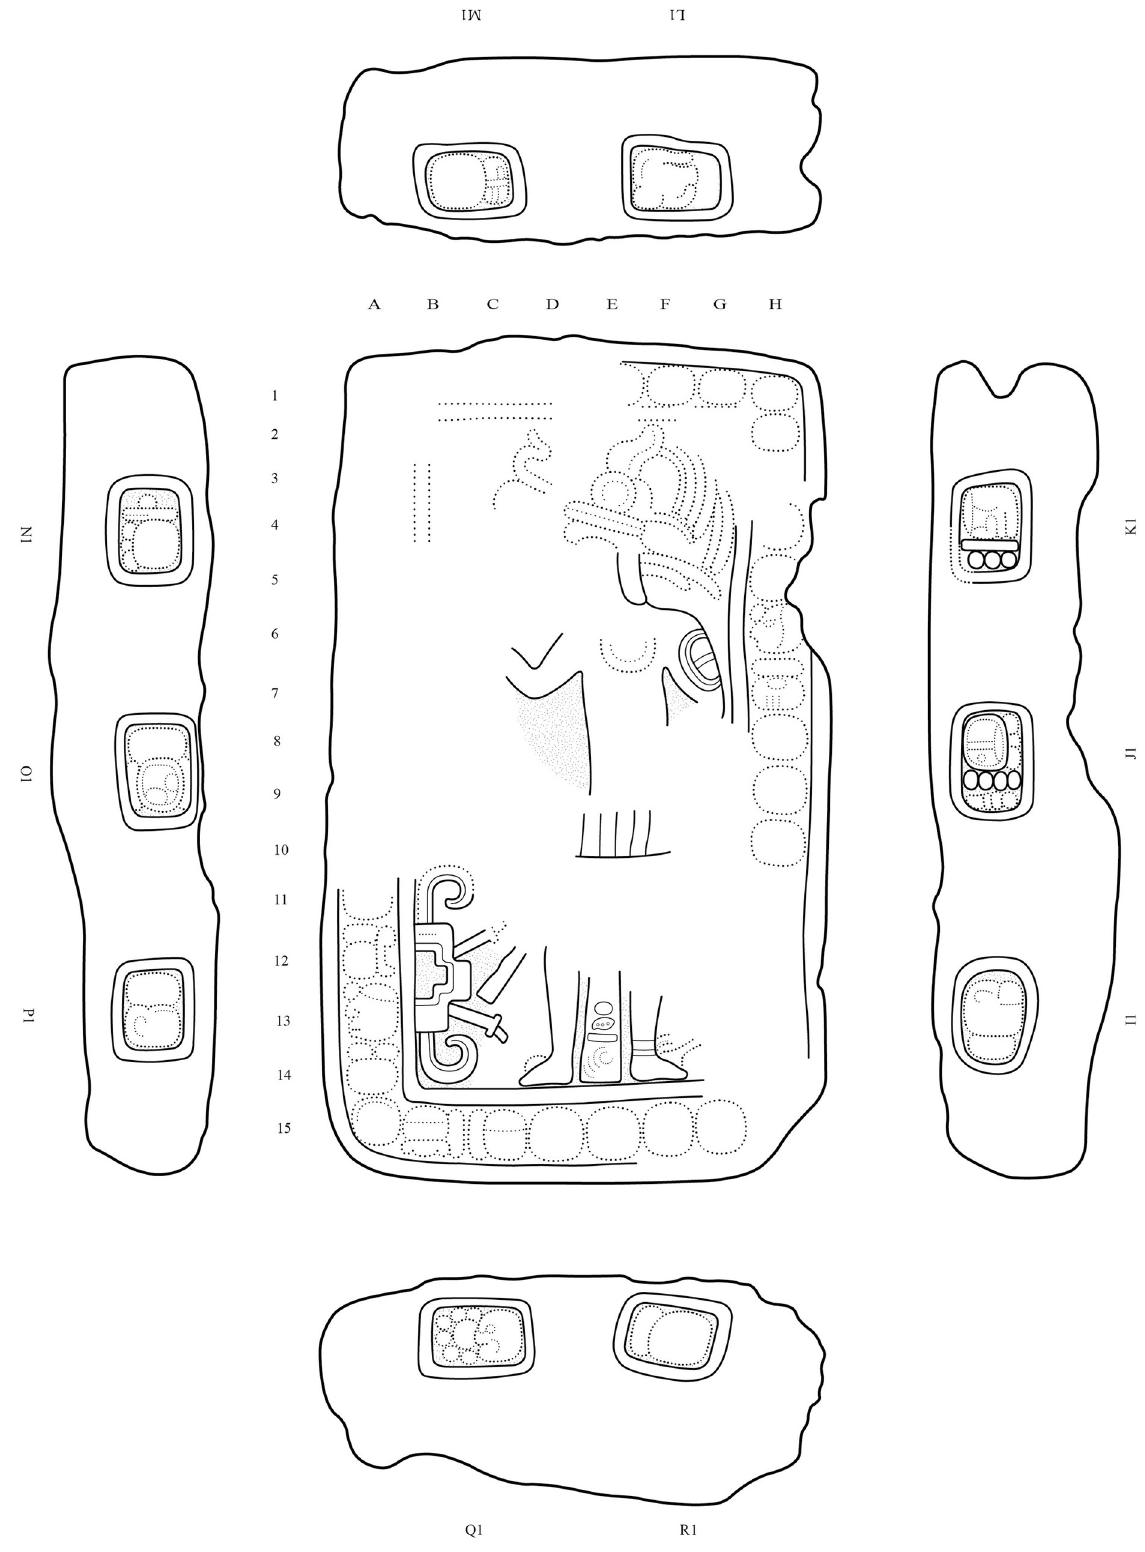
Fig 12. CHRP Altar 1 (length: 1.47 m, width: 0.87 m, thickness: 0.4 m), showing a local dignitary accompanied by a hieroglyphic text, which includes a partially preserved toponymic title (A12-A13) (drawing by Octavio Esparza Olguı´n). https://doi.org/10.1371/journal.pone.0262921.g012 PLOS ONE | https://doi.org/10.1371/journal.pone.0262921 January 21,